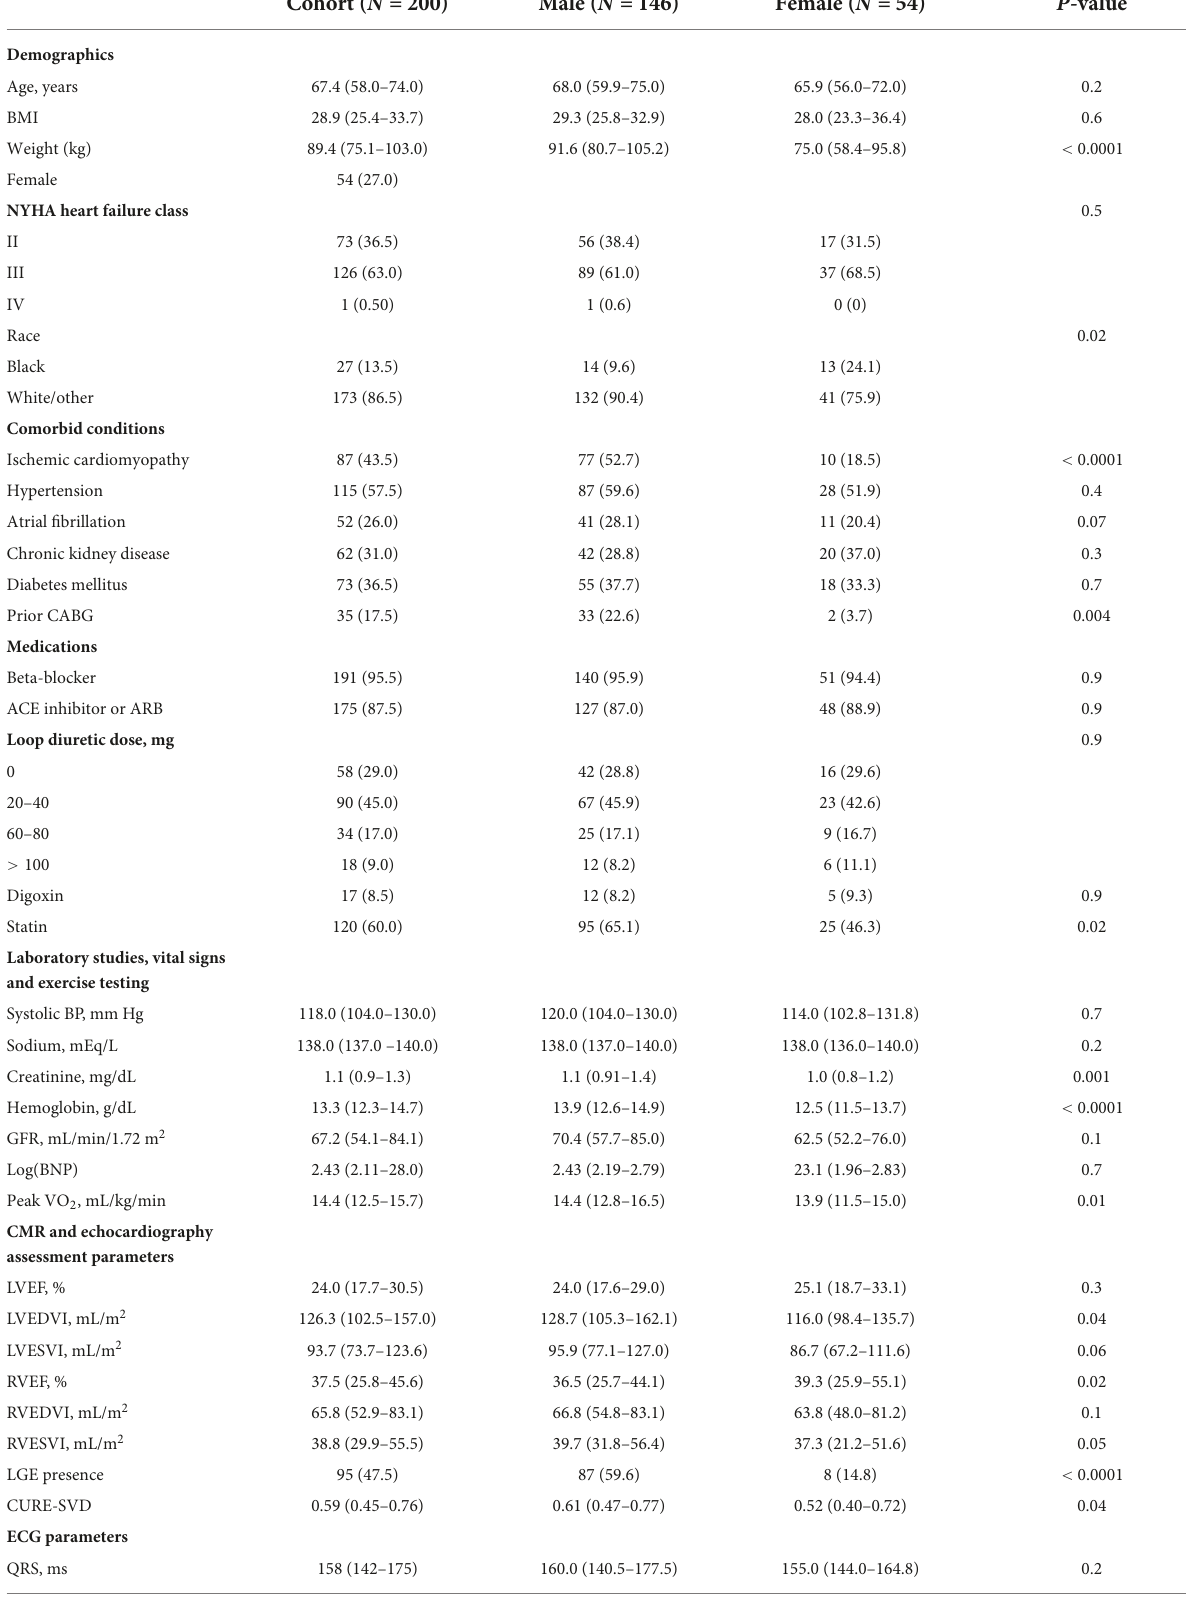
TABLE 1 Baseline characteristics and CRT response measures of patient cohort and male vs.